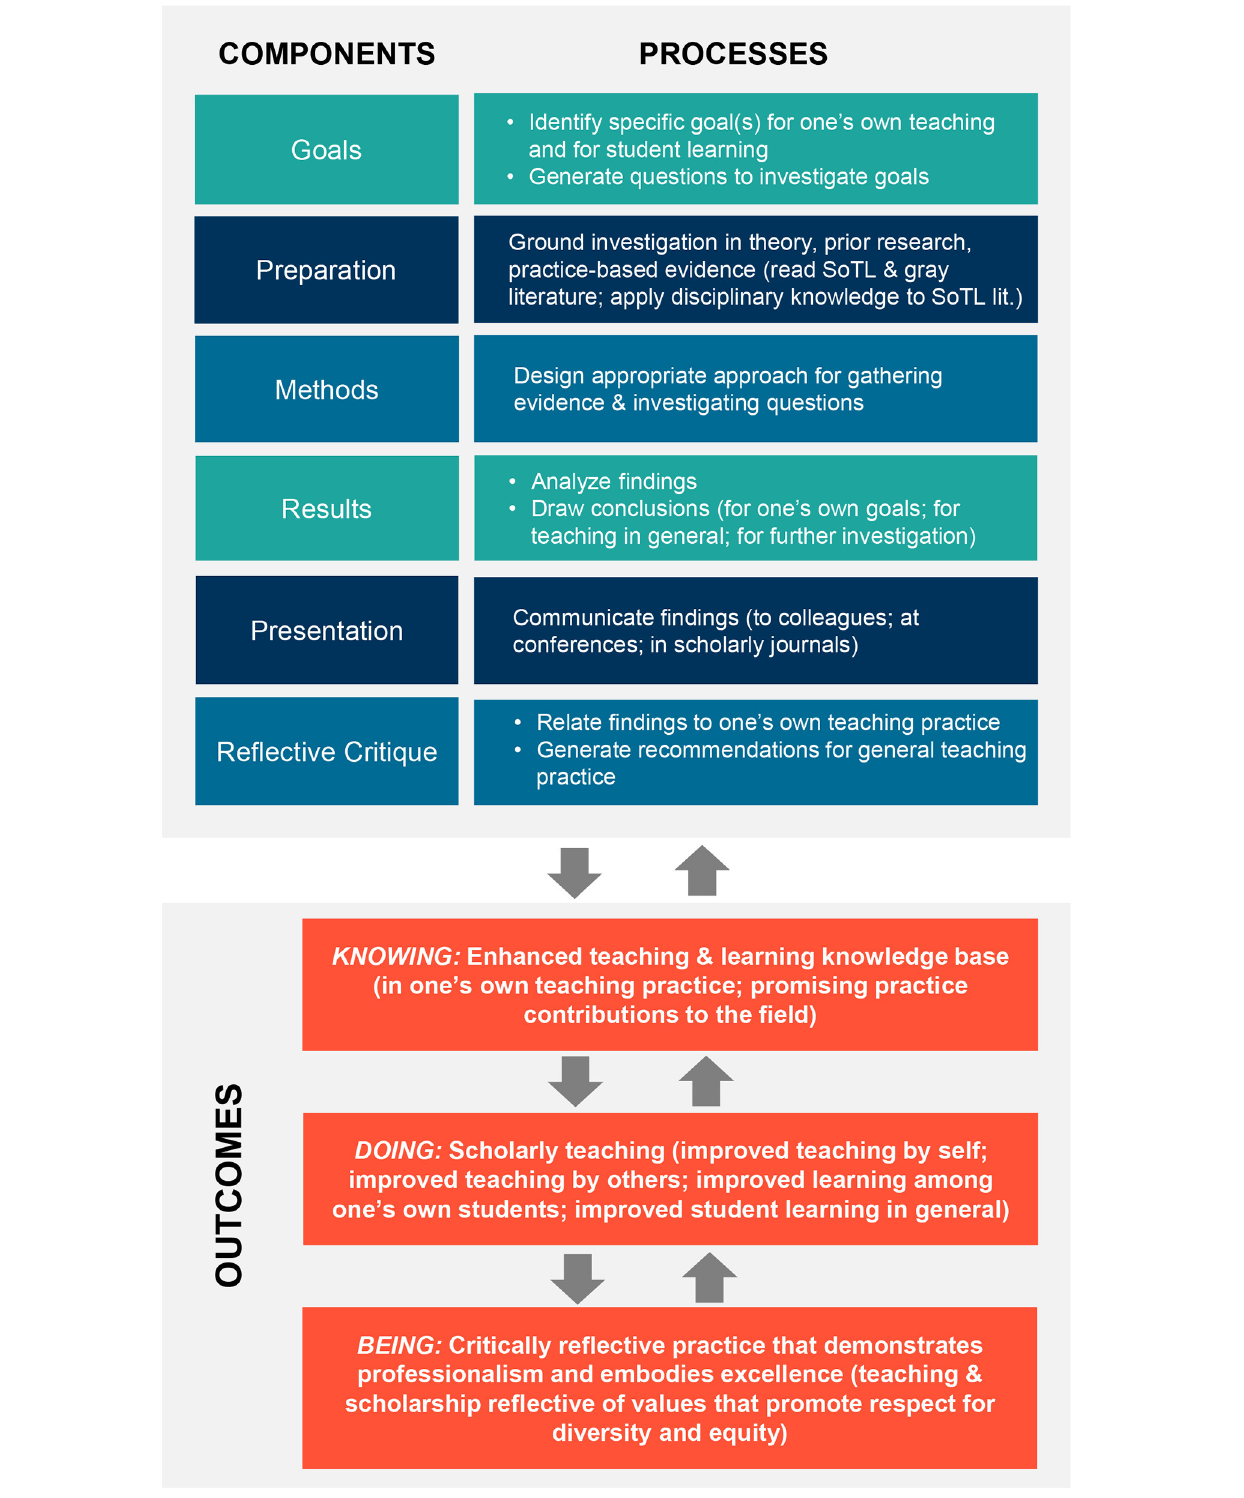
FIGURE 1 | Model for scholarly teaching in action and practice (STAP) [adapted from Bishop-Clark and Dietz-Uhler (16), Cox (17), Glassick et al. (18), and Trigwell et al. (15)].